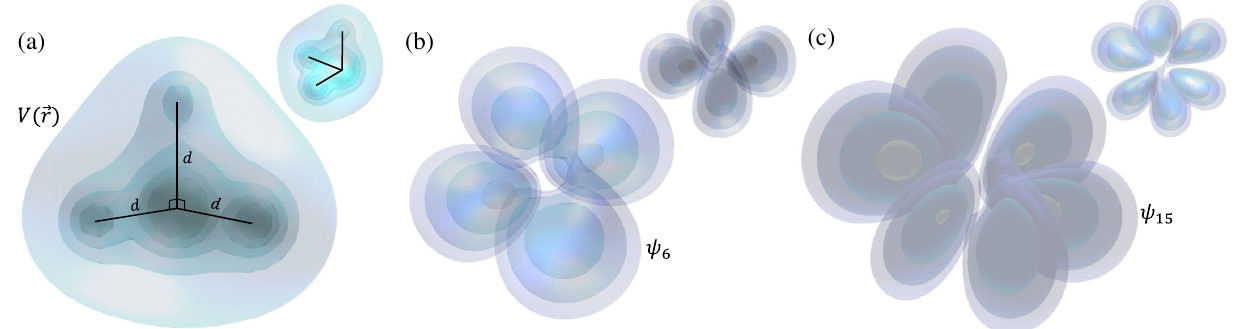
FIG. 6. Isosurface plots for (a) the chiral model potential, (b) the sixth orbital, and (c) the 15 th orbital. In each subfigure, a second viewpoint is shown in the inset. Isosurfaces for the potential are s ¼ 0 . 15 , 0.3, 0.4, 0.5, 0 . 6 V